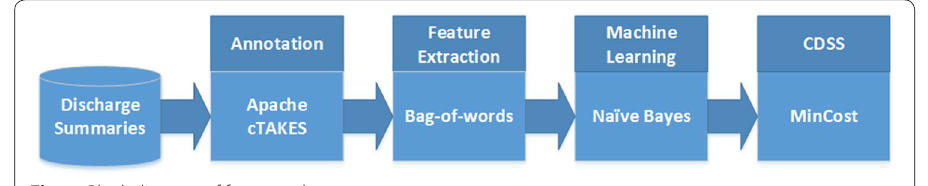
Fig. 4 Block diagram of